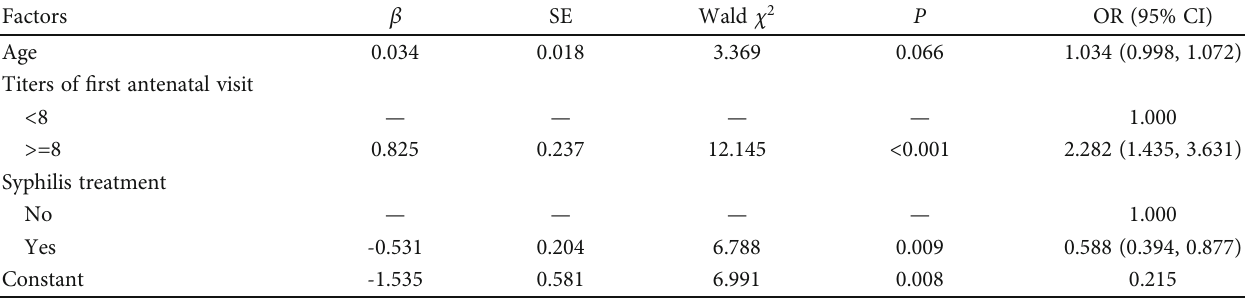
Table 2: Logistic regression model analysis of factors related to adverse pregnancy outcomes among syphilis-infected pregnant women.